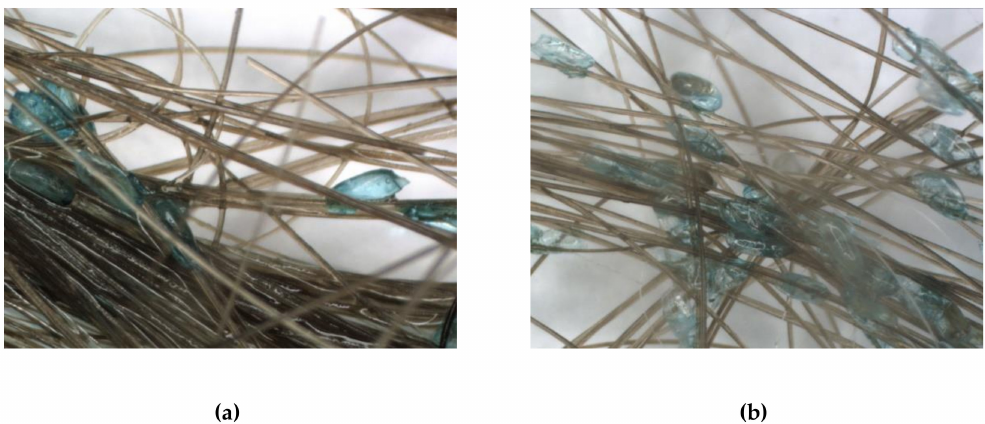
Figure 3. Staining of eggshells using the 0.5% Patent Blue gel (Apaisyl ® D é tect Lentes). ( a ) Nits on clean hair when the gel was applied; ( b ) Nits on hair previously treated using a silicone-based head louse elimination product, from which residues of silicone oil remained on the hair after